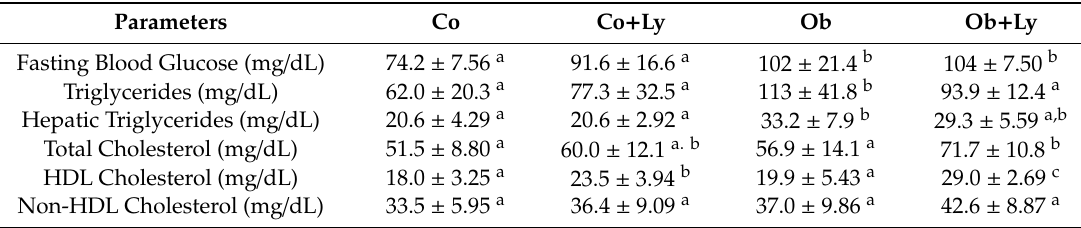
Table 4. Markers for lipid and glucose metabolism.